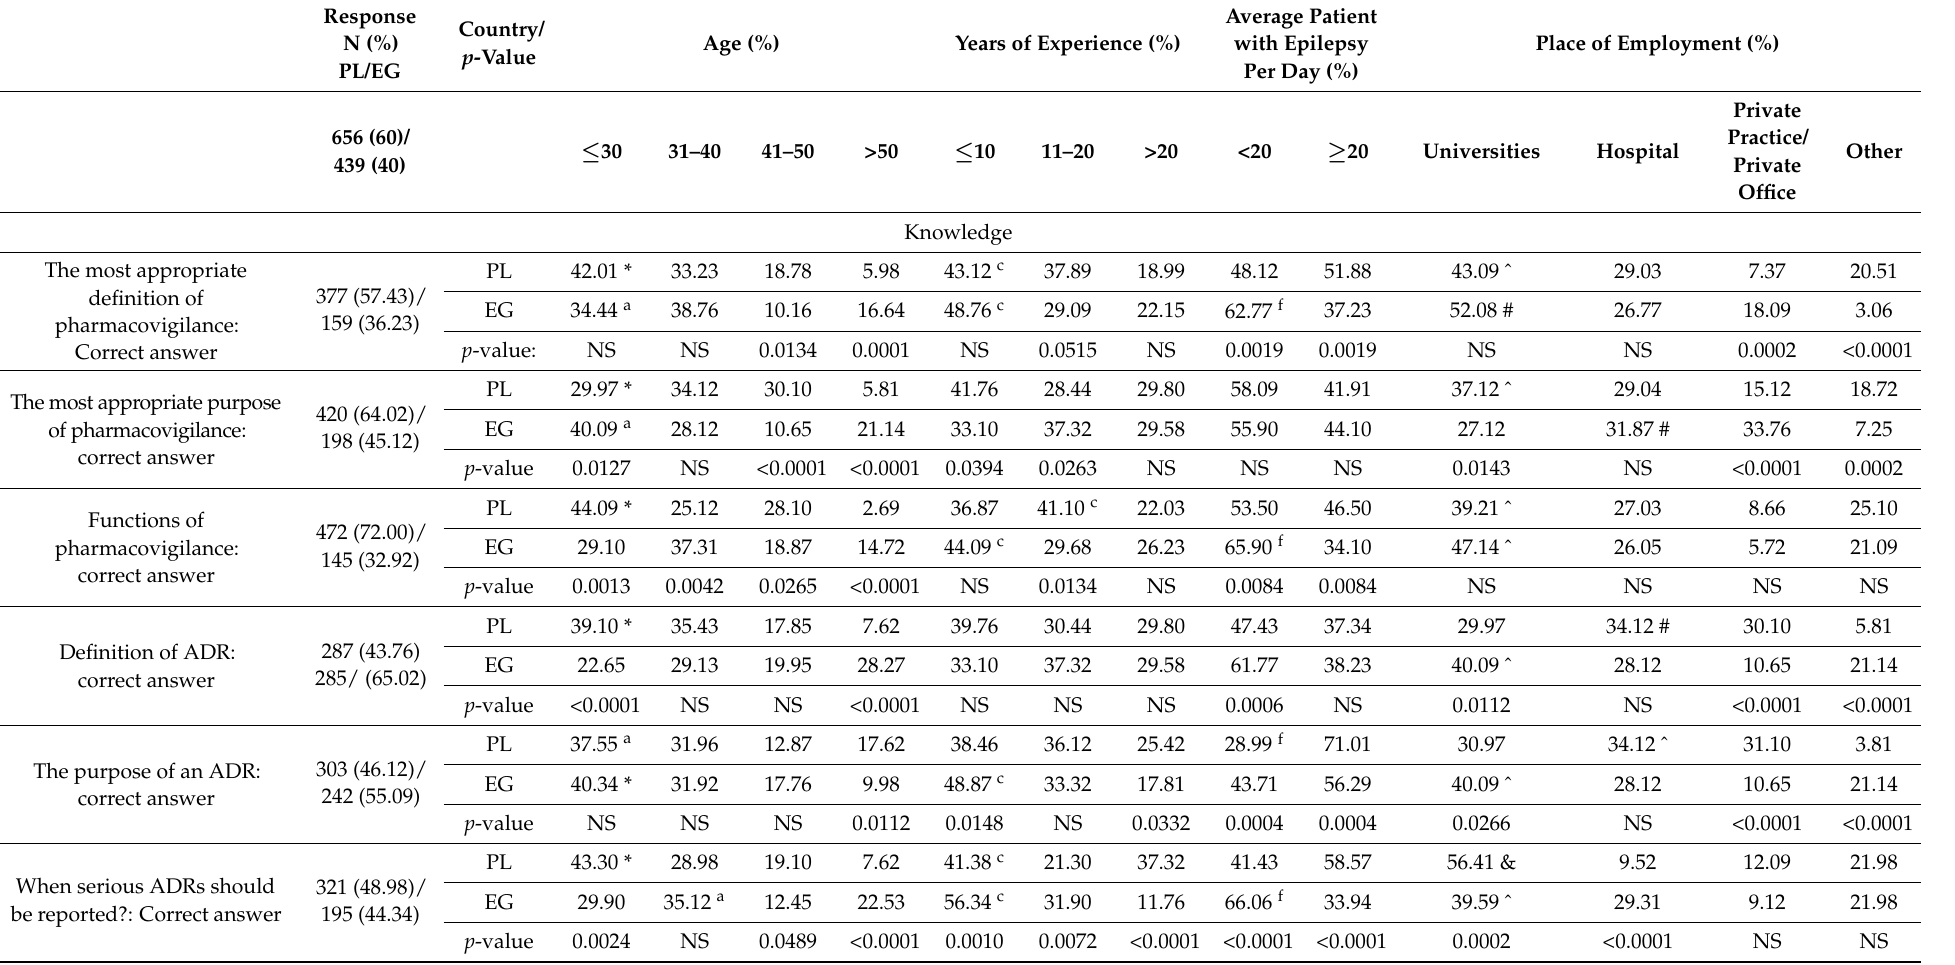
Table 2. Assessment of neurologists’ knowledge about pharmacovigilance and adverse drug reactions ( n =